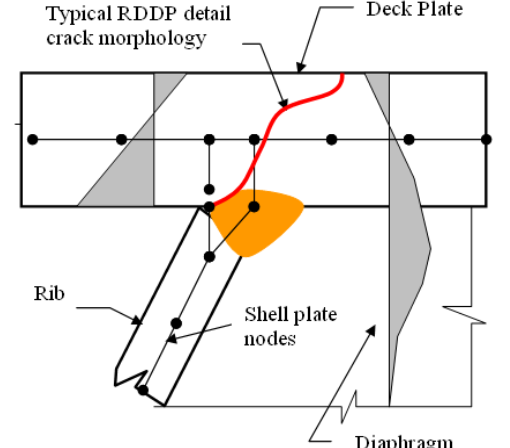
Figure 8: Fatigue cracks at RDDP connection (Camo,